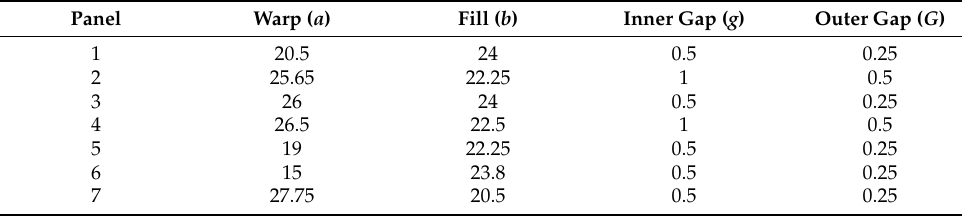
Table 3. Sizes, inner gap, and outer gap of each panel type.